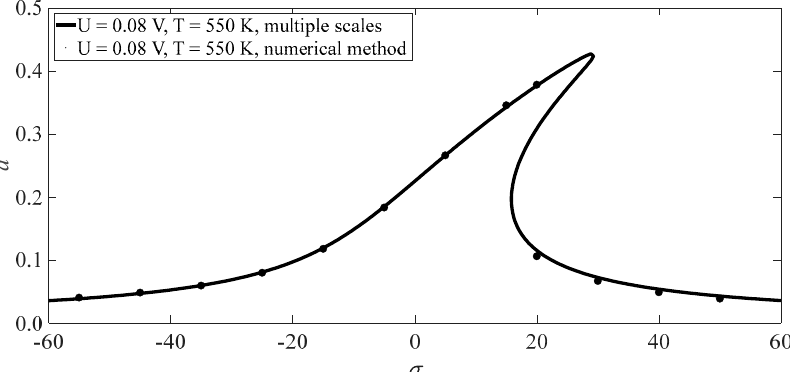
Figure 4. Frequency − response curves of the second mode with ( c 2 , f 2 ) = ( 5,15 )